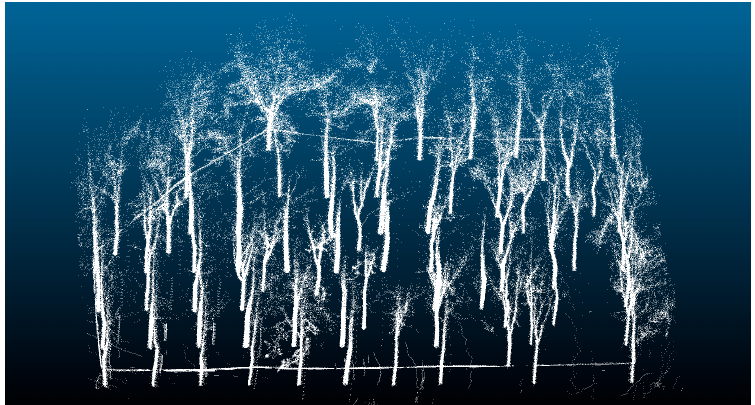
Figure 4 . 3D point cloud map without the ground area.